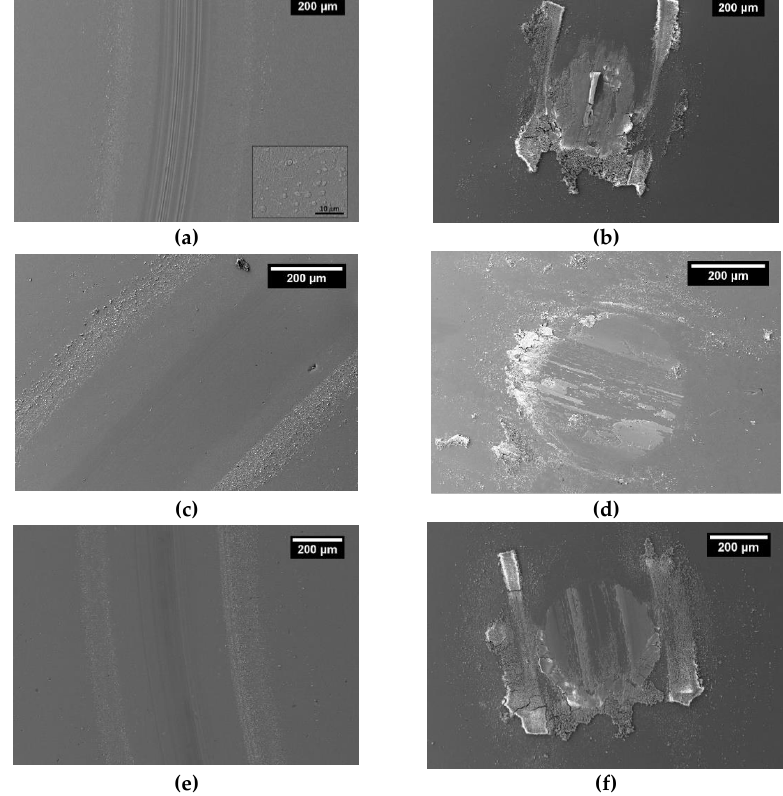
Figure 7. SEM images of the coating wear track: ( a ) DCMS, ( c ) HIPIMS, and ( e ) HIPIMS CH4, and the crater in the steel ball after testing by pin on disk at room temperature, ( b ) DCMS, ( d ) HIPIMS, ( f ) HIPIMS